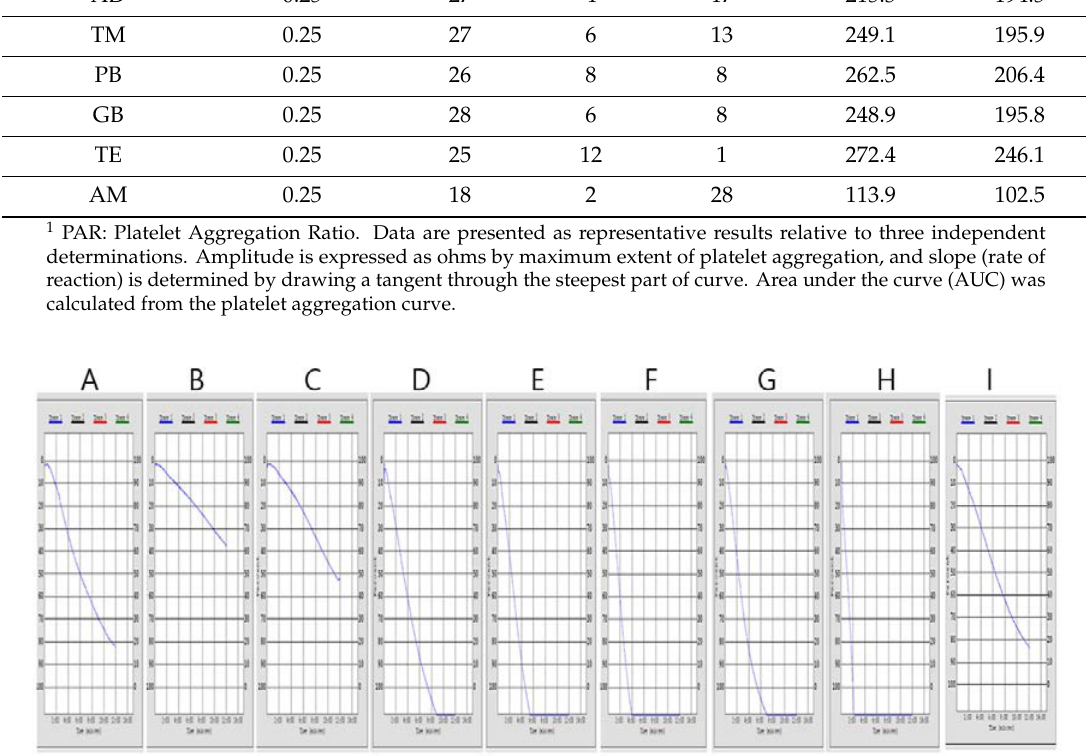
Figure 2. Impedance changes during platelet aggregation after addition of aspirin and the insect extracts in whole blood aggregometer. ( A ) DMSO, ( B ) aspirin (0.25 mg / mL), ( C ) aspirin (0.125 mg / mL), ( D ) AD extract (0.25 mg / mL), ( E ) TM extract (0.25 mg / mL), ( F ) PB (0.25 mg / mL), ( G ) GB extract (0.25 mg / mL), ( H ) TE extract (0.25 mg / mL) and ( I ) AM extract (0.25 mg / mL), respectively.